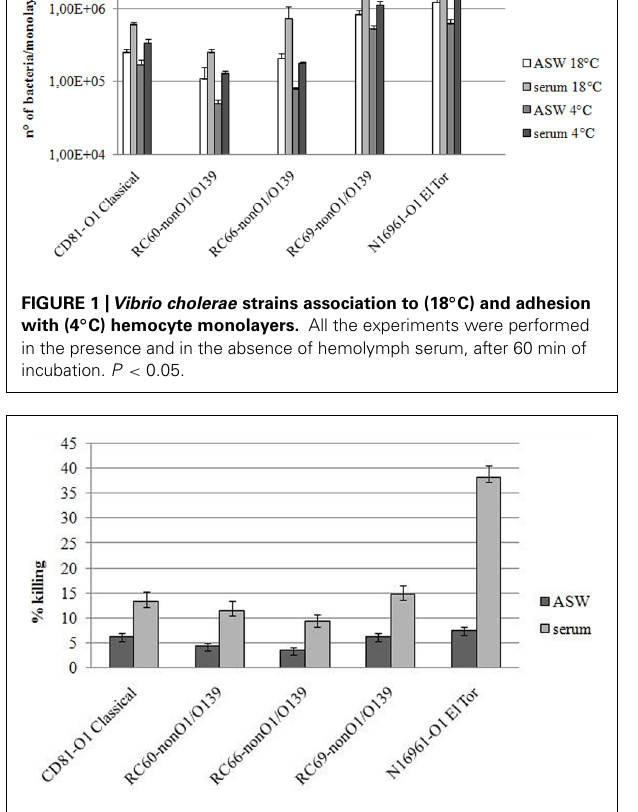
FIGURE 2 | Vibrio cholerae strains killing by hemocyte monolayers. All the experiments were performed in the presence and in the absence of hemolymph serum, after 60 min of incubation. P <